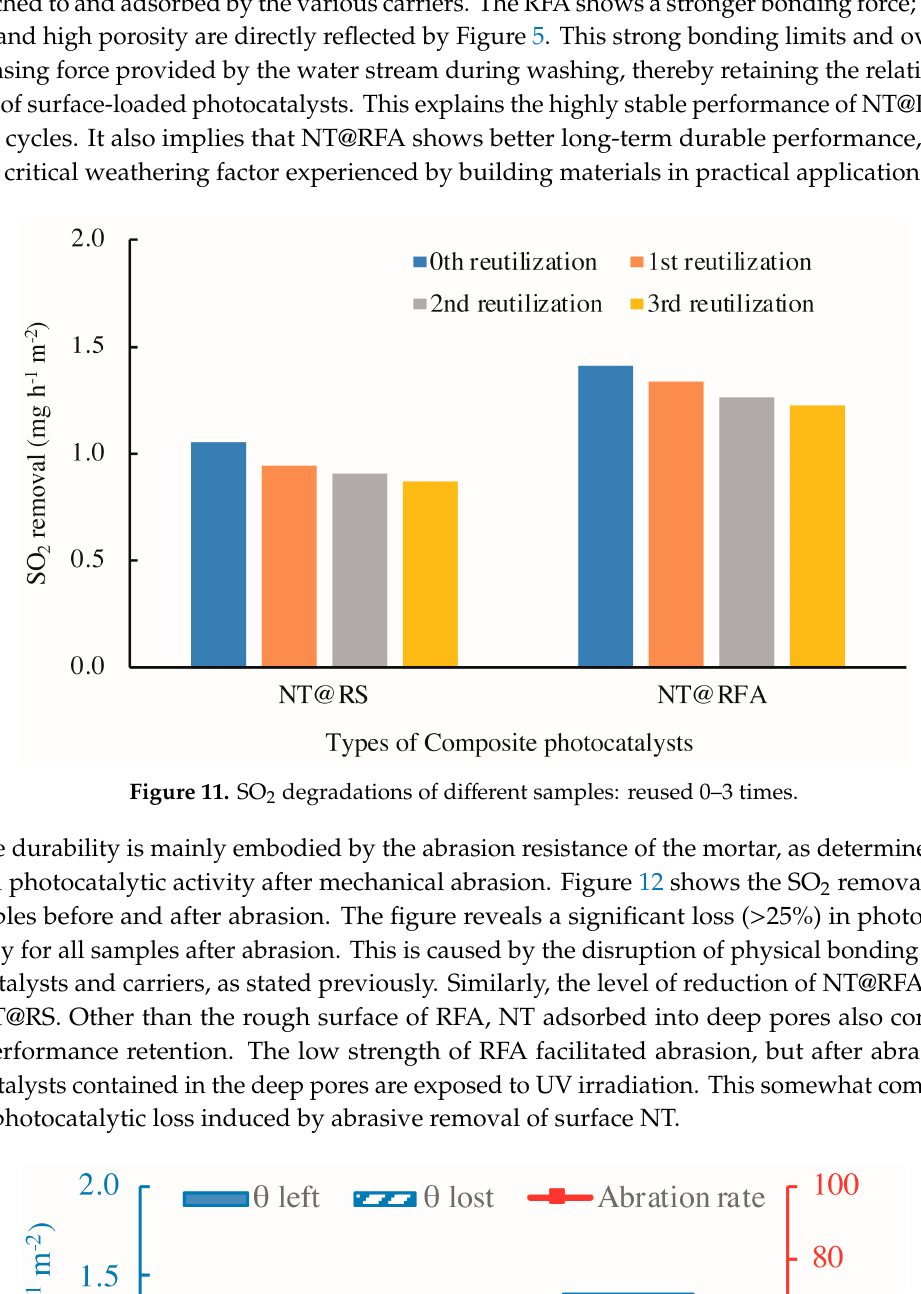
Figure 12. SO 2 degradations of different samples: before and after abrasion.